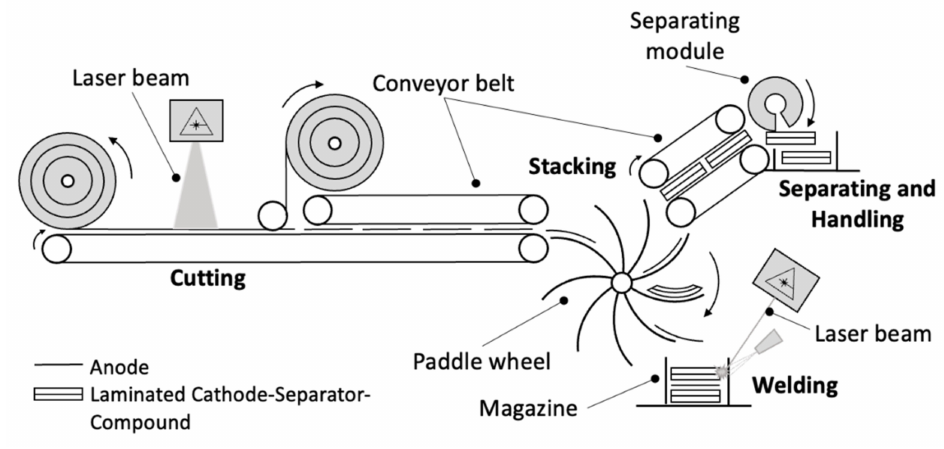
Figure 2. Architecture of the stacking process in the research project